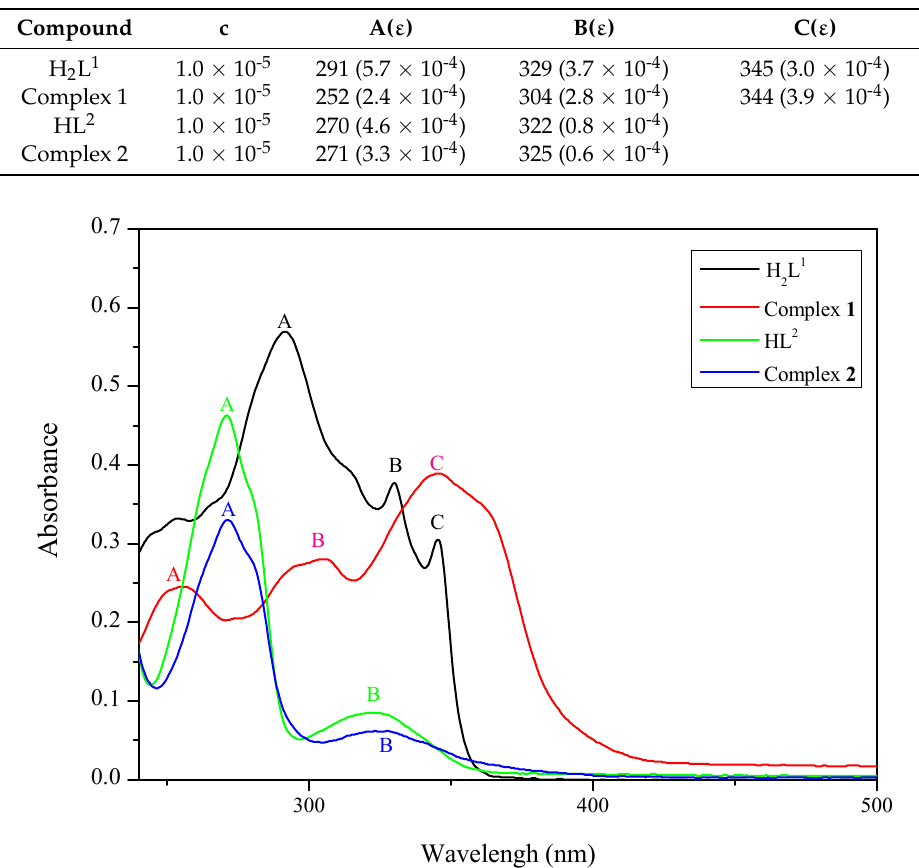
Table 6. Absorption maxima and molar extinction coefficients for complexes 1 and 2 .